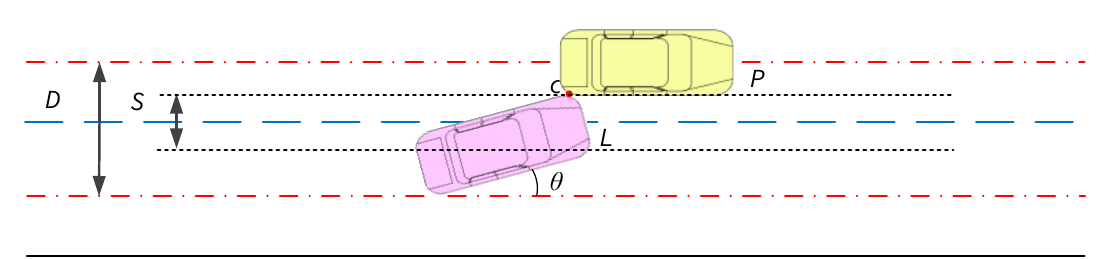
Figure 14. The position of cut-in vehicle L and preceding vehicle P.